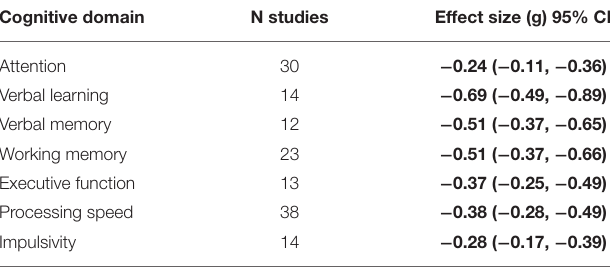
TABLE 1 | Acute effects of cannabis use on cognitive